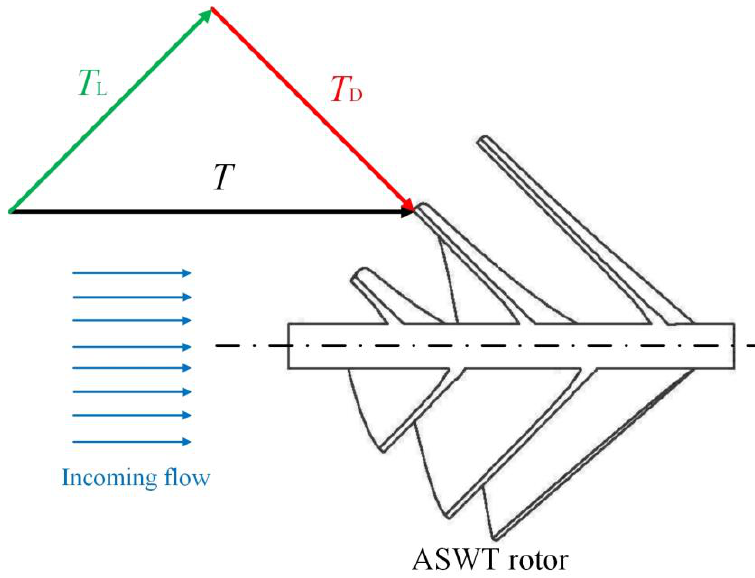
Figure 2. Aerodynamic force analysis on the ASWT rotor.